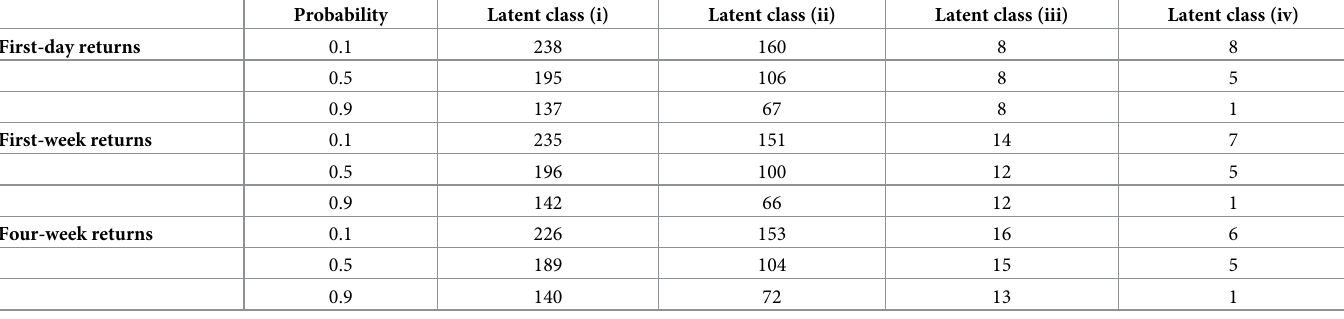
Table 10. Predicted number of IPOs in each latent class for different thresholds of the posterior probability using first-day, first-week and four-week returns on the issuing firms’